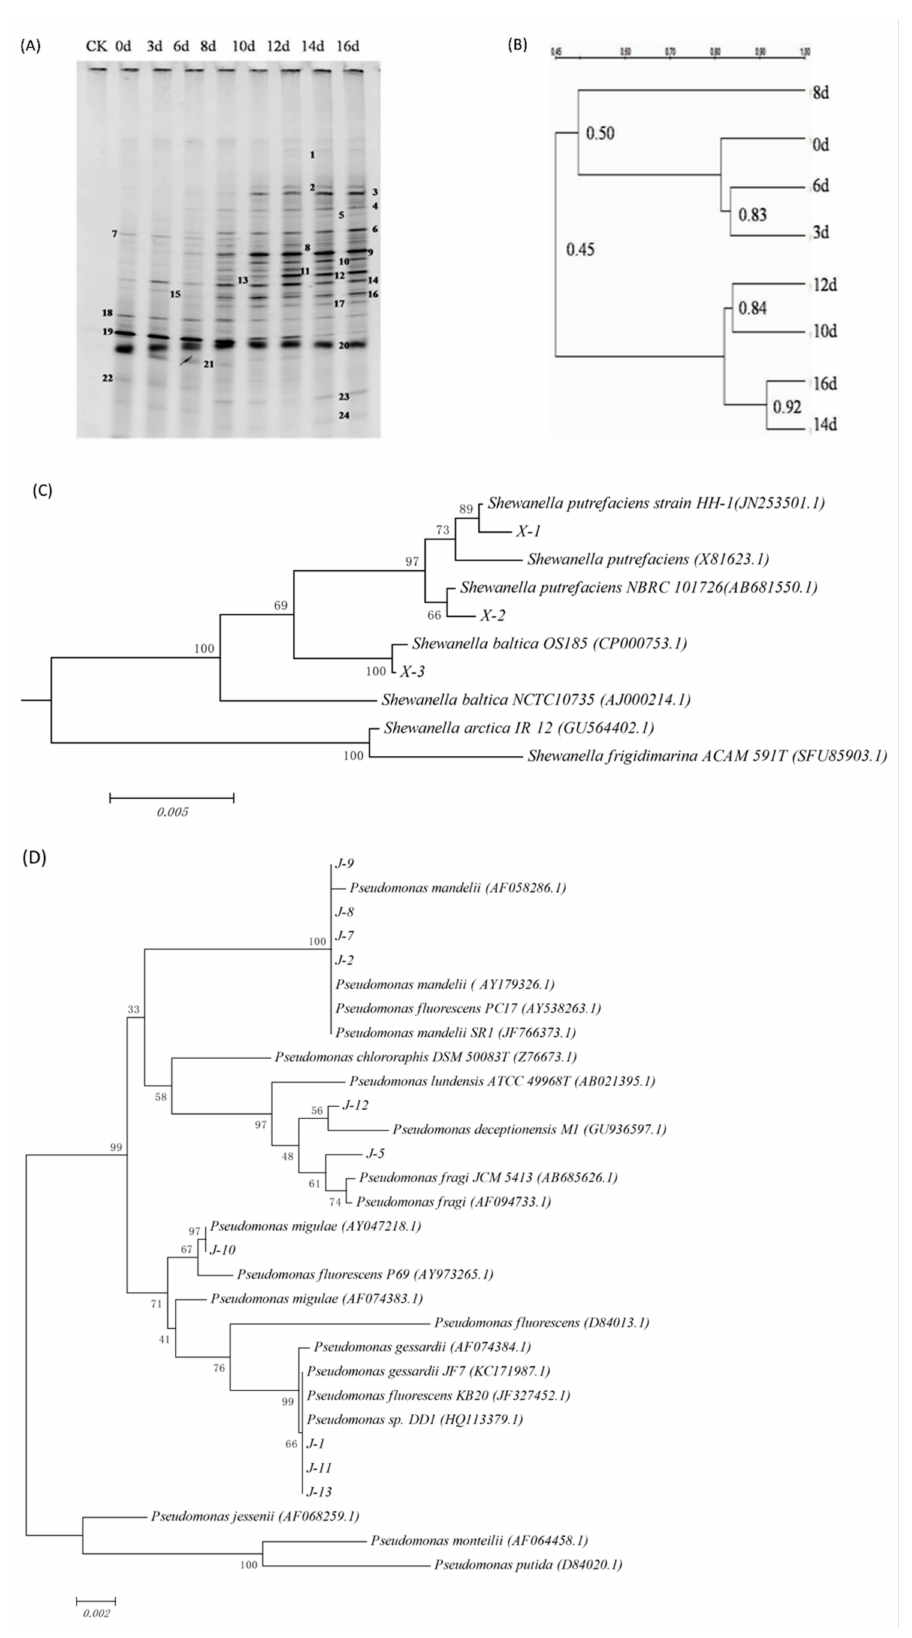
Figure 1. Analysis of DGGE Atlas. DGGE profile of bacteria from sturgeon stored aerobically on ice ( A ). Cluster analysis of DGGE bacteria profile ( B ). Phylogenetic tree of the 16S rRNA gene of Shewanella sp. isolated from sturgeon fillets ( C ). Phylogenetic tree of the 16S rRNA gene of Pseudomnas sp. isolated from sturgeon fillets ( D